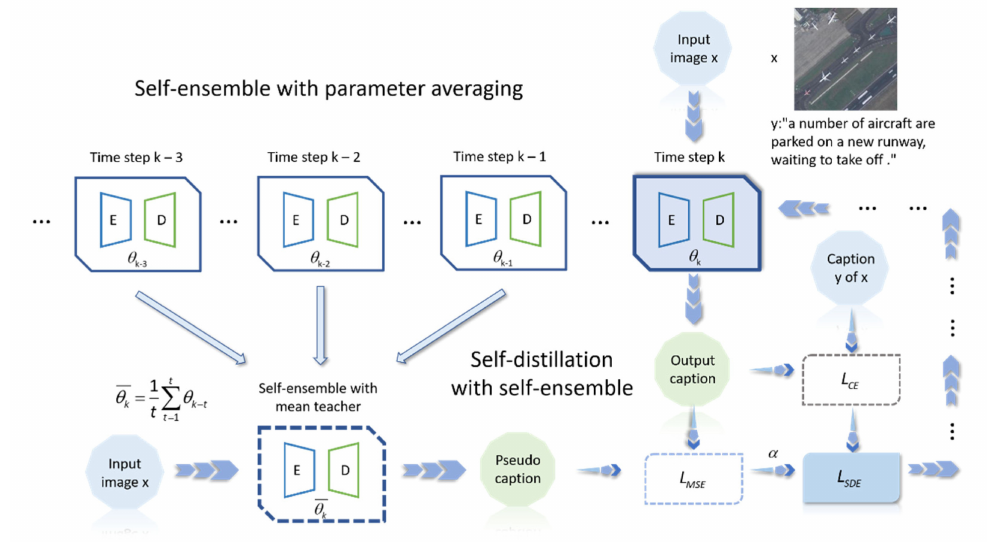
Figure 3. Schematic diagram of self-distillation training strategy with self-ensemble we proposed. x represents the input remote sensing image, and y represents the caption label of x . The self-ensemble we construct contains the average of model parameters: a self-ensemble mean teacher model with exponential moving average is constructed according to the different morphologies of the model itself in the recent t training steps. The caption generated by the self-ensemble model will be sent to the self-distillation process as a pseudo caption label. Self-distillation separately calculates the mean square error L MSE of the output captions generated by the k-generation model with pseudo